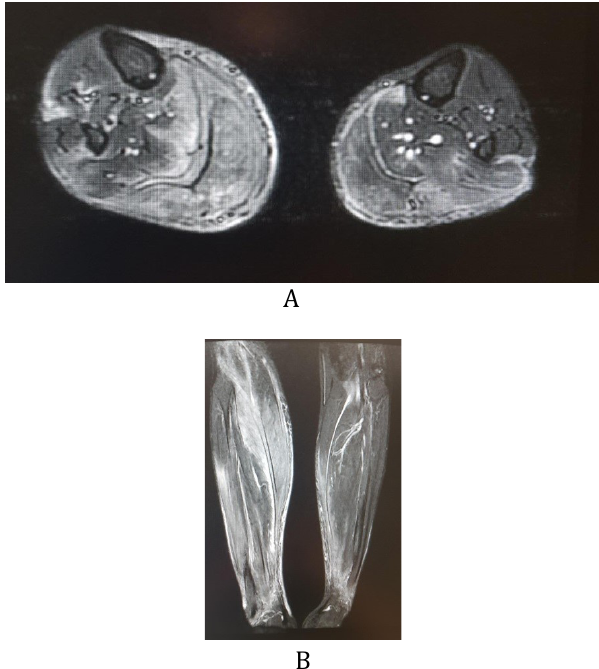
Figure 1. Muscular MRI. A: axial stir, showing myositis; B: coronal stir showing